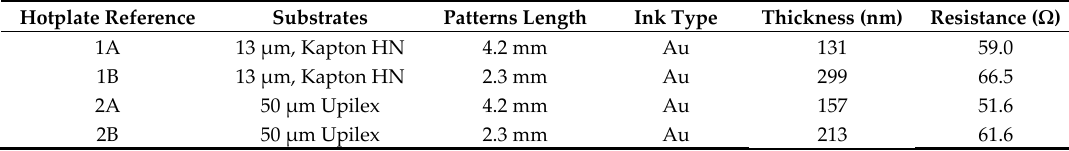
Table 1. Summary of devices printed using Aerosol Jet